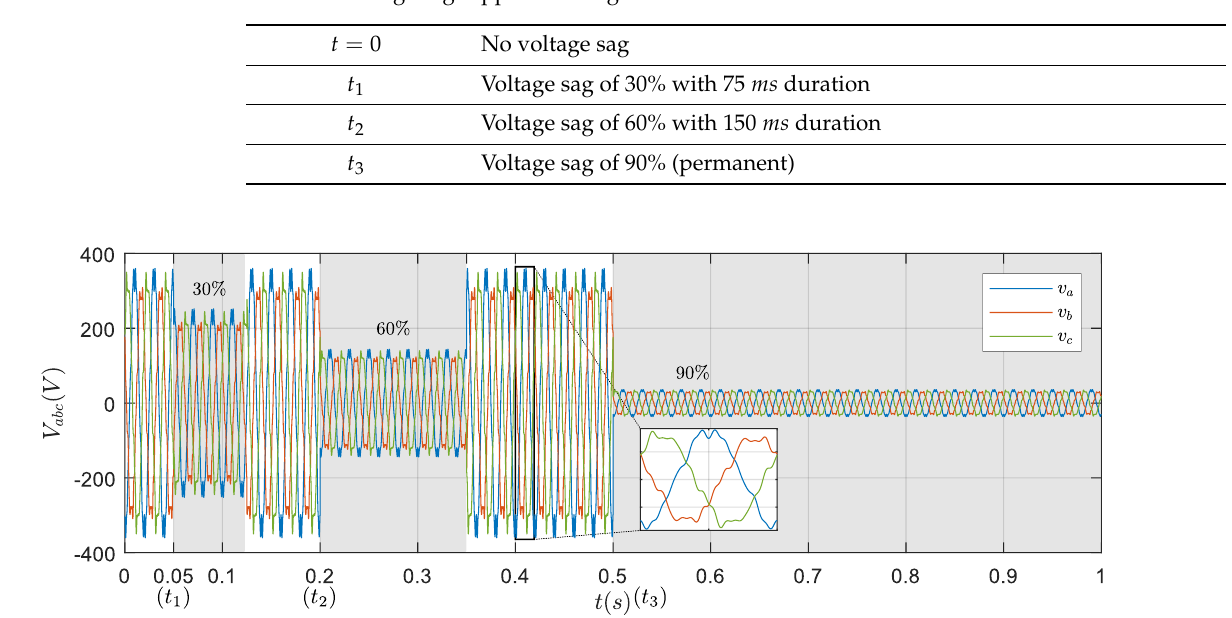
Table 10. Voltage sags applied during test #3.